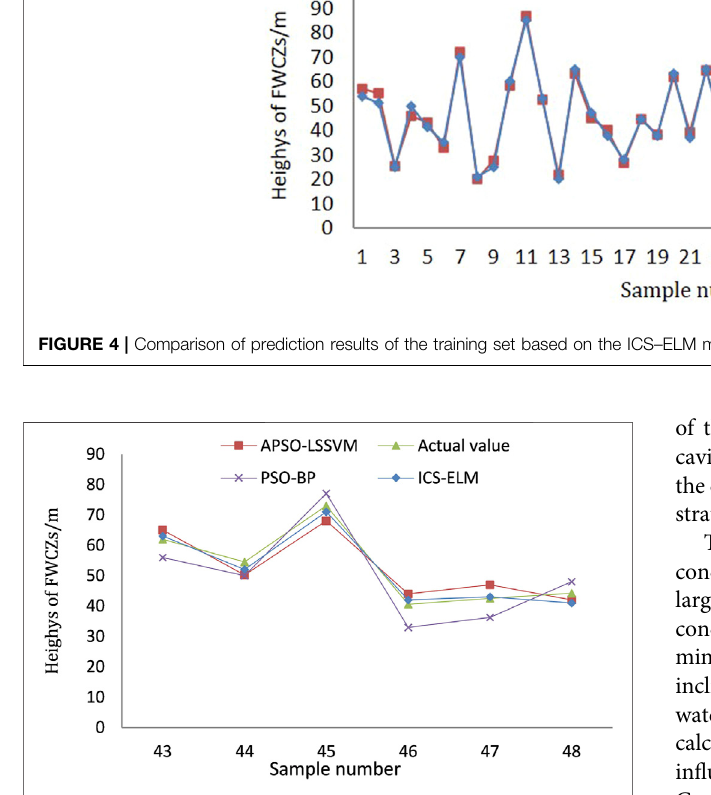
FIGURE 5 | Comparisons of prediction results obtained by the APSO – LSSVM, PSO – BP and ICS – ELM models.